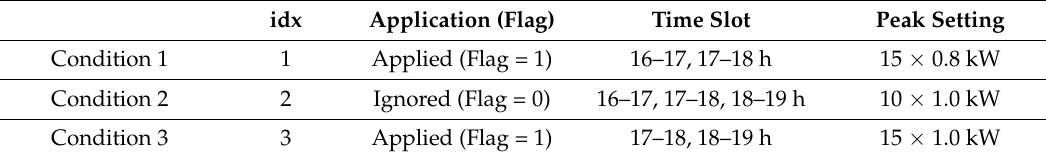
Table 8. Peak control operating condition.